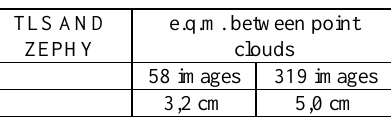
Table 3. E.Q.M. between TLS point cloud